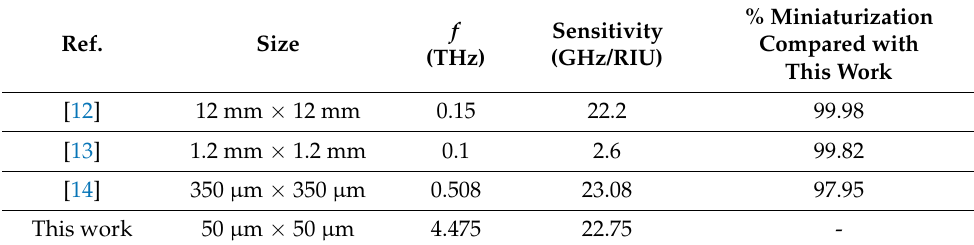
Table 3. Performance comparison with other relevant THz sensors.